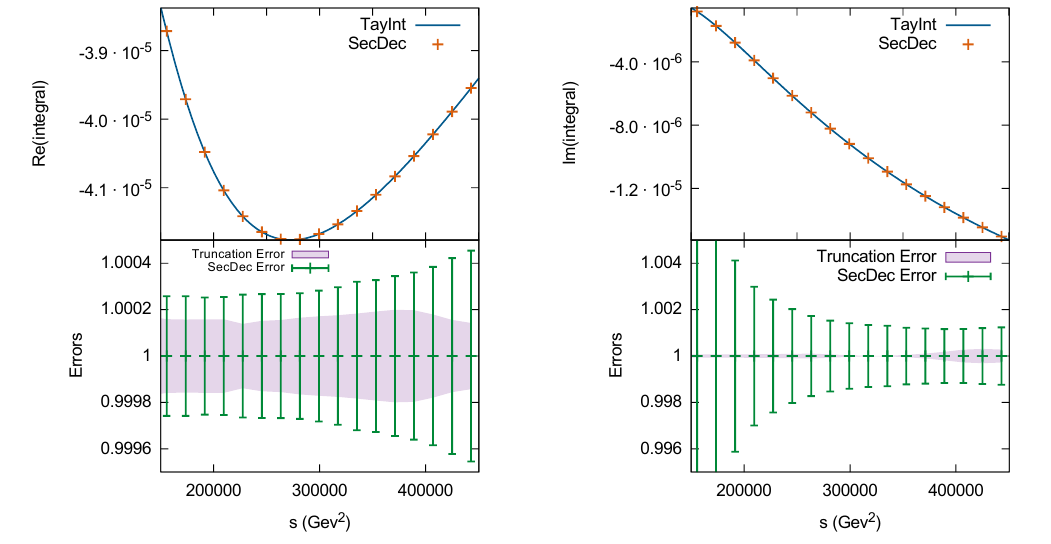
Figure 19 . The I39 Integral calculated at O ( (cid:15) 0 ) with a fourth-order series expansion. The scale s is over the 4 m 2 threshold, with u = (cid:0) 59858GeV 2 , m 2 = 1 p 1 plots show the relative TayInt and SecDec uncertainties,